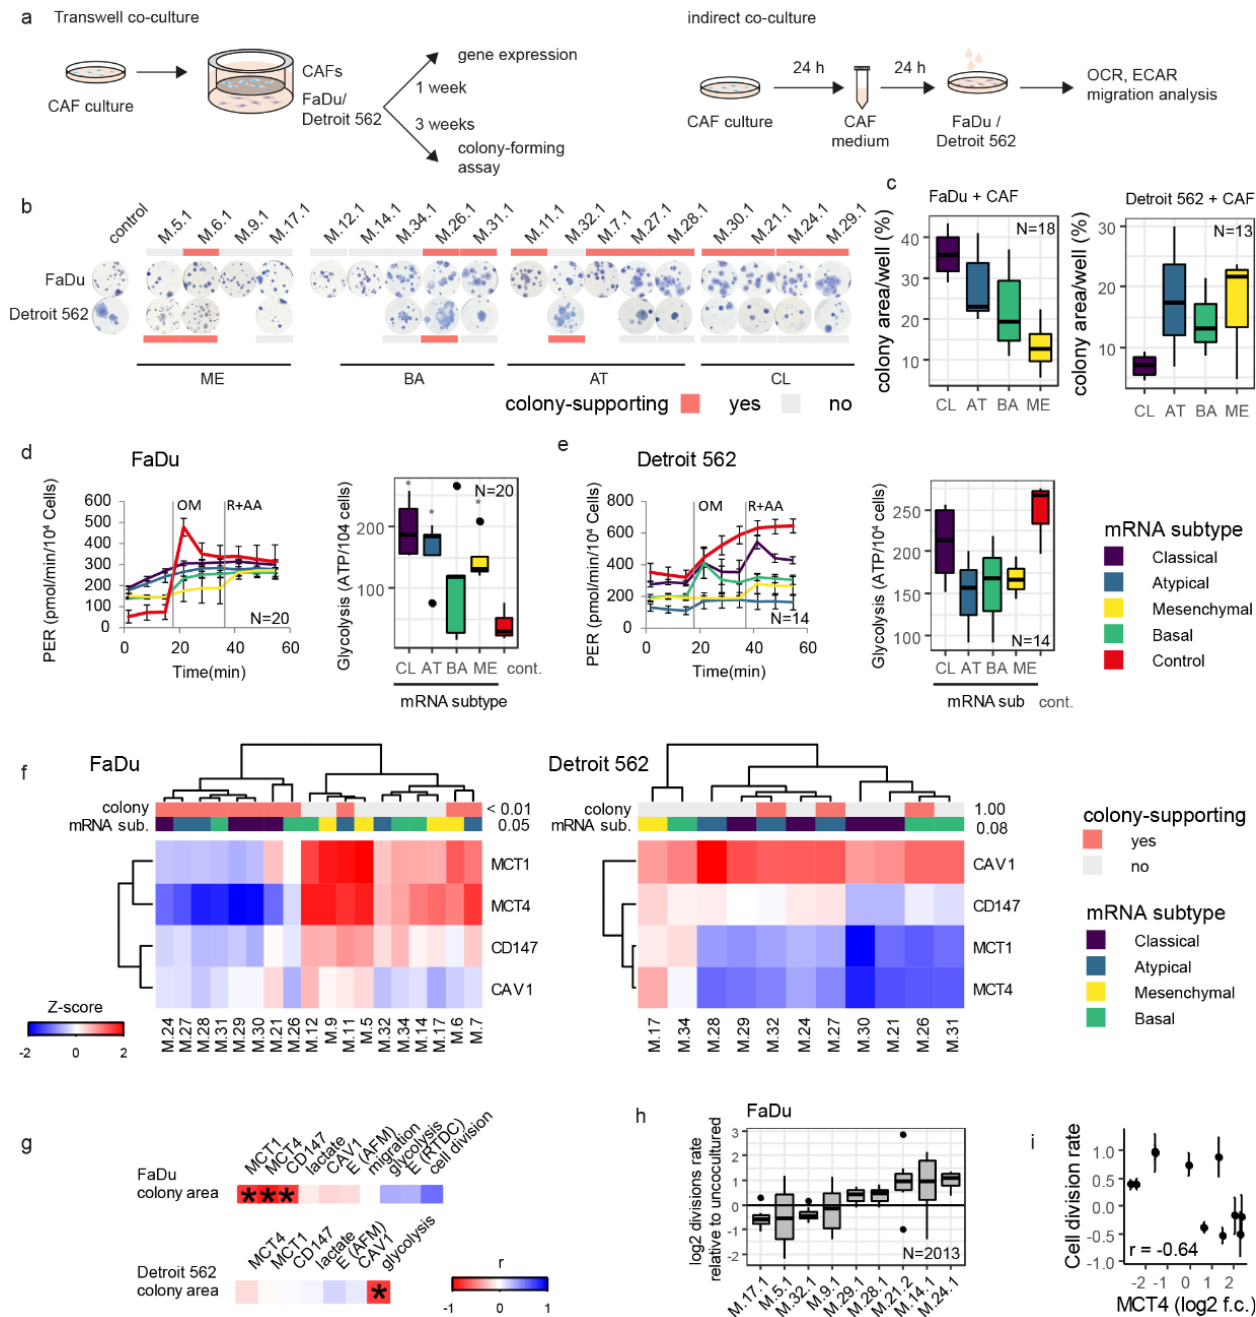
Figure 2. Cancer cell colony-forming capacity and lactate shuttling are reprogrammed by CAFs through coculture. ( a ) schematic of Transwell coculture and indirect coculture with conditioned media. ( b ) colony-forming assay, cancer cells Transwell-cultured with CAFs; colony-supporting indicate p < 0.05 for colony size vs. non-cocultured control (see Figure S2). Measurements were performed in triplicate. ( c ) cancer cell colony area affected by CAFs derived from tumour tissues of varying mRNA subtypes. CL, classical, AT, atypical, BA, basal, ME, mesenchymal. CAFs derived from tumour tissues of different mRNA subtypes affect FaDu ( d ) and Detroit 562 ( e ) glycolytic ATP production differently. Performed in triplicate; PER = Proton efflux rate, rate of protons extruded into the extracellular medium during glycolysis. ( f ) expression of lactate-shuttle-relevant genes in cancer cell lines is associated with tumour tissue-of-origin mRNA subtype and colony-supporting status after CAF coculture. ( g ) correlation heatmap of the colony-forming assay with lactate-shuttle-relevant